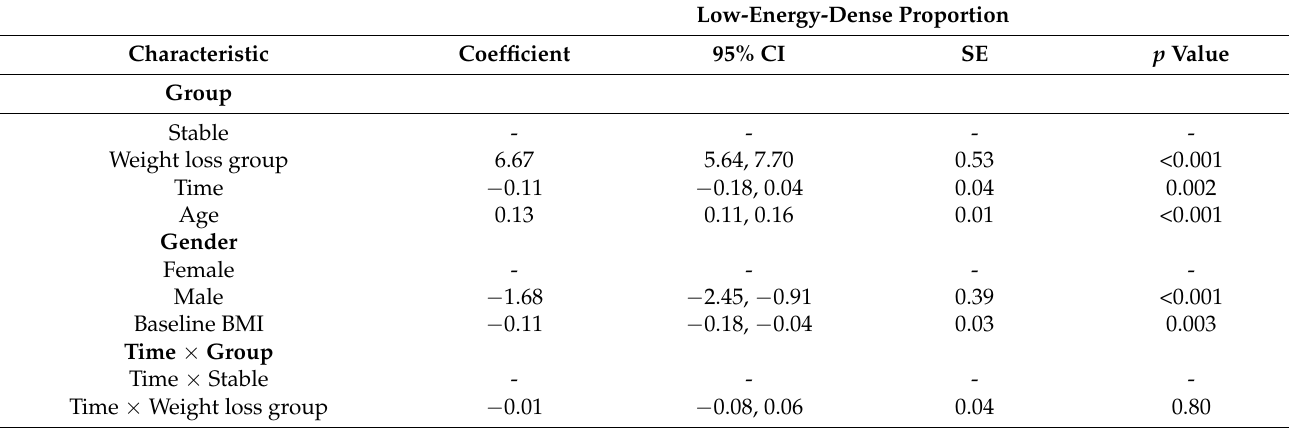
Table 3. Linear mixed models predicting weekly low-energy-dense proportions for 4-month participants. Low-Energy-Dense